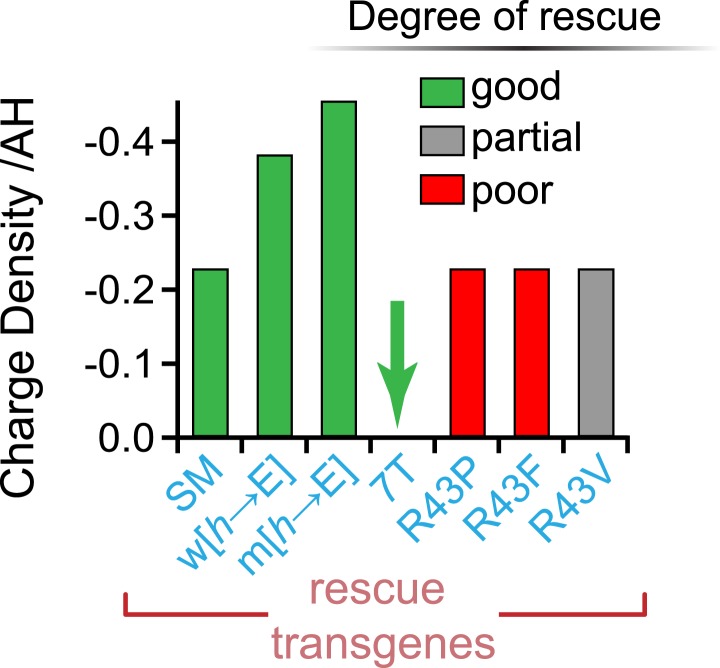
No correlation between charge density and function.Charge density of the AH domain in seven rescuing CPX-1 variants. Green indicates nearly complete rescue, gray is partial, and red is poor rescue as measured by aldicarb sensitivity. The CPX-1 variants are mouse AHshort (SM), worm AH with hydrophobic to glutamates (w[h→E]), mouse AH with hydrophobic to glutamates (m[h→E]), 7-turn helix substitution (7T), as well as the R43P, R43F, and R43V substitutions.